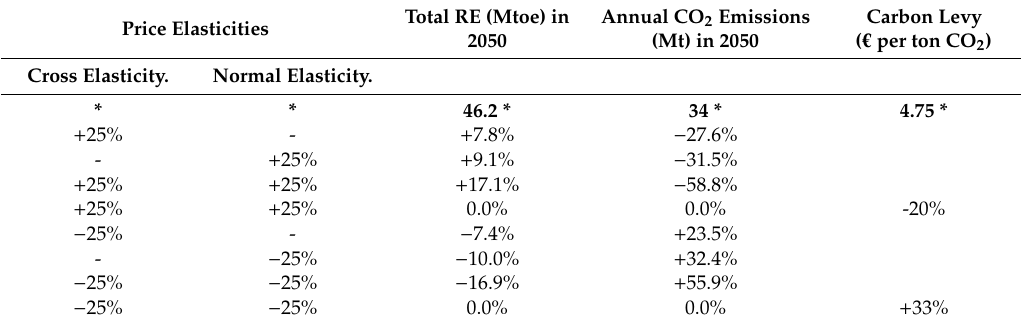
Table 7. Sensitivity analysis price elasticities (* is initial simulation result of CL RE scenario). Price Elasticities Cross Elasticity.